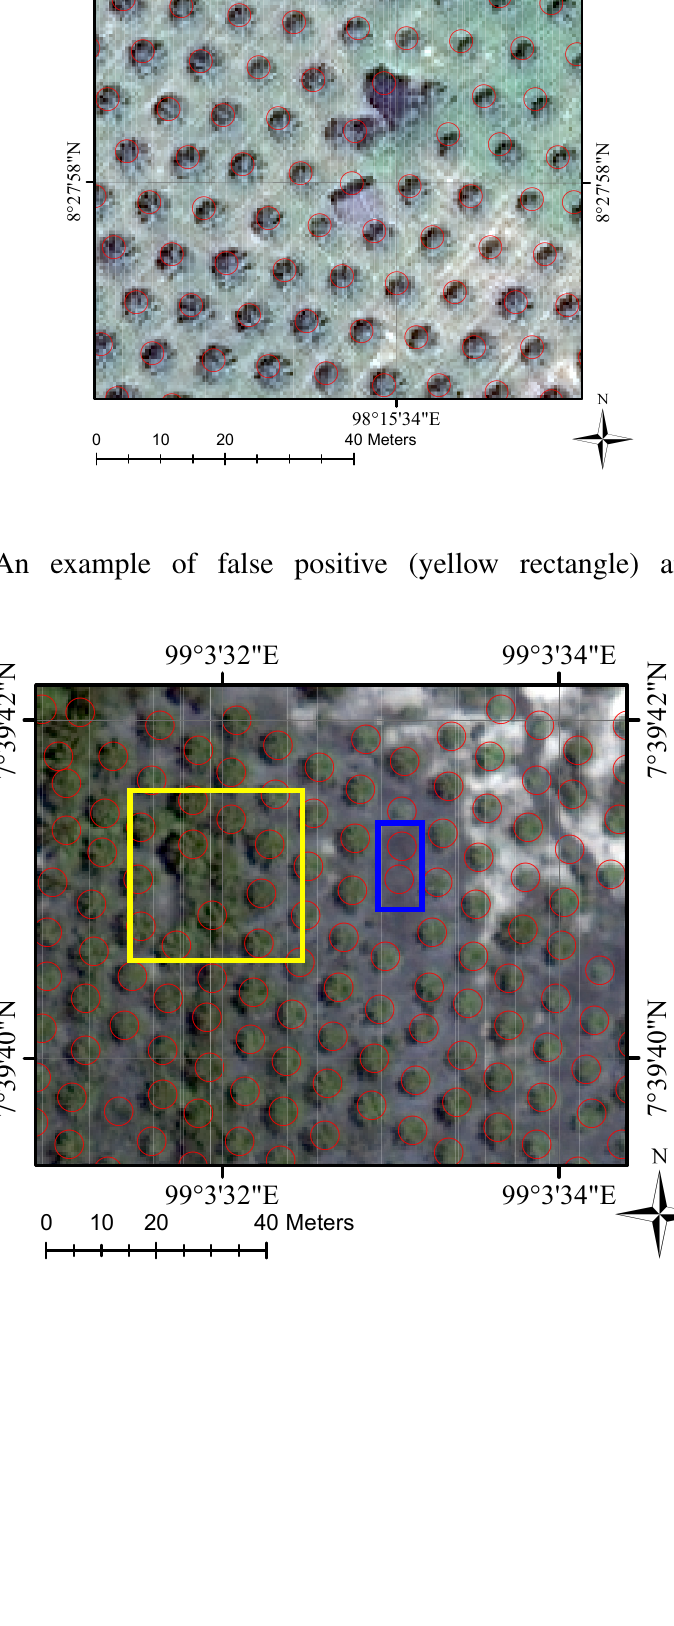
Figure 12. An example of false positive.